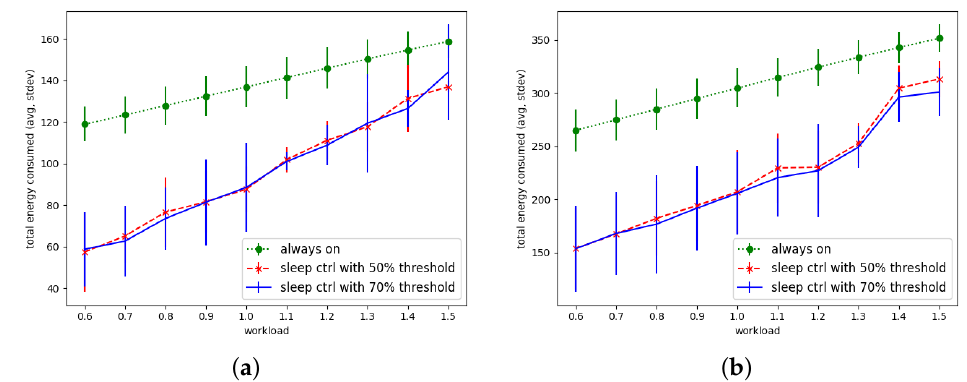
Figure 8. Total energy consumed when all MECSs were able to directly communicate with each other. ( a ) when the number of MECSs is 10; ( b ) when the number of MECSs is